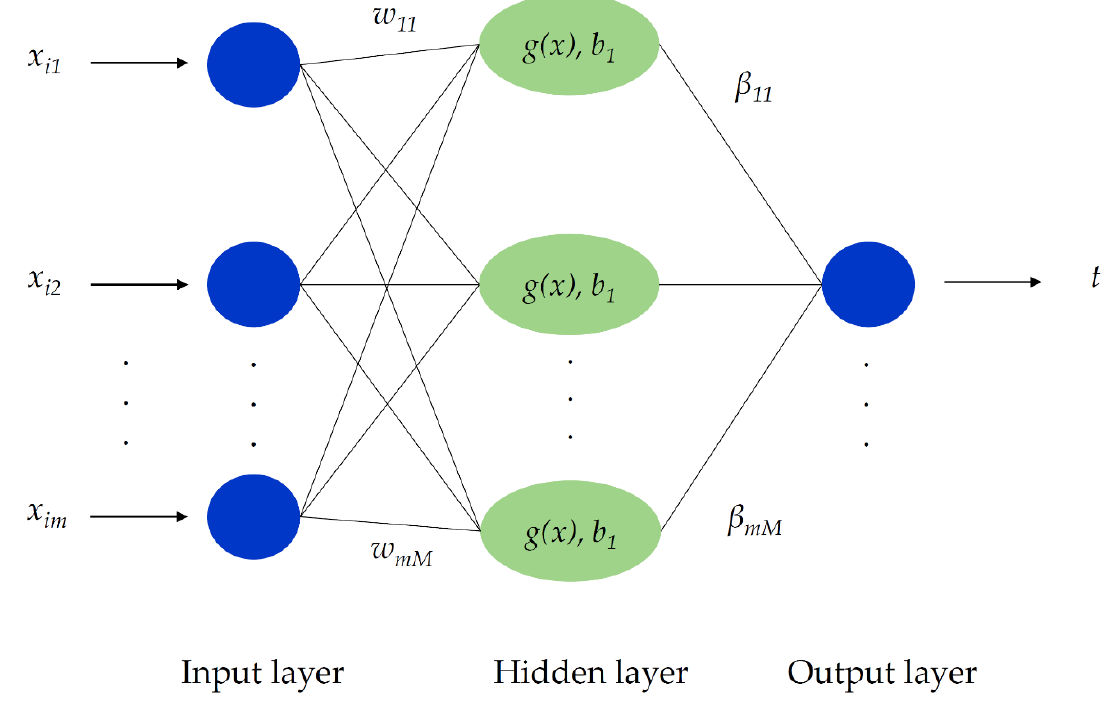
Figure 2. Extreme learning machine (ELM) structure.